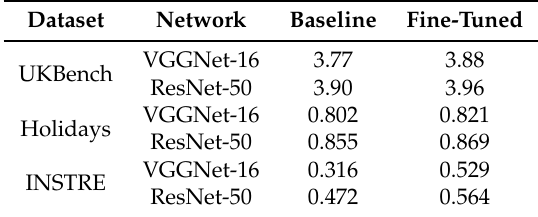
Table 4. Performance comparison between baseline and fine-tuned model with different backbones. Retrieval accuracy is measured by the N-S Score for the UKBench dataset and mAP for the Holidays dataset and the INSTRE